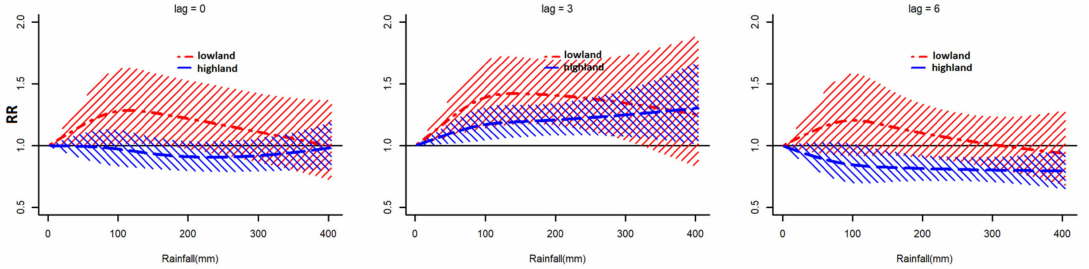
Figure 4. Pooled lag-specific rainfall–malaria associations by area.